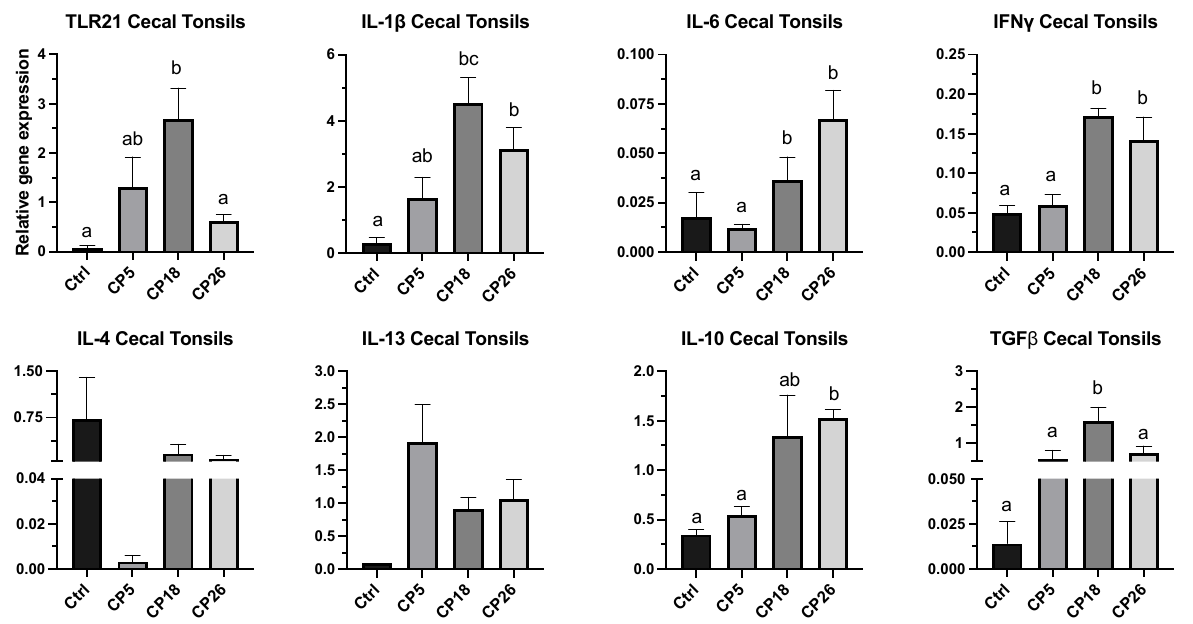
Figure 4. Effect of C. perfringens on immune system gene expression in the cecal tonsils of broiler chickens. One-day-old commercial broiler chickens were fed an antibiotic-free diet and challenged with one of three different C. perfringens strains along with the uninfected control via intracloacal inoculation on day 18 of age, administered twice daily for 4 consecutive days, followed by necropsy on day 22. Cecal tonsils were collected in RNAlater for RNA extraction and cDNA synthesis. Real- time PCR to quantify the expression of IL-1 β , IL-4, IL-6, IL-10, IL-13, IFN γ , TLR-21, and TGF β genes was performed, along with the housekeeping gene ( β -actin). The expression levels are shown as relative to β -actin. Different letters above the standard error of mean bars indicate significant differences ( p < 0.05) between the groups. Ctrl—Control (uninfected); CP— C. perfringens strain. As shown in Figure 5, the expression of IL-1 β and IL-13 genes in CP5-infected birds was higher ( p < 0.05) compared to the control, CP18, and CP26 groups. Additionally, the expression of IL-10 in all infected groups was increased ( p < 0.05), while the TLR21 expres- sion was decreased ( p < 0.05) in all the infected groups when compared to the uninfected control. No significant changes were observed in the transcription of IL-6, IFN γ , IL-4, and TGF β between any of the treatment groups.